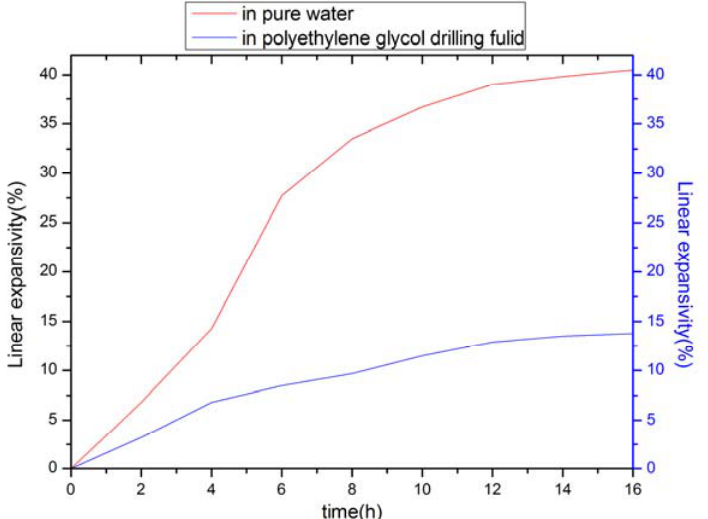
Figure 2. The shale expansion in the pure water and the drilling fluid.